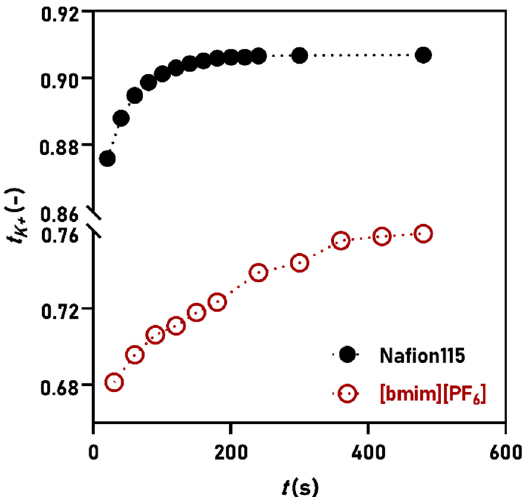
Figure 4. Time-course of K + transport numbers in the case of Nafion and [bmim][PF 6 ] membranes. Additionally, this value implies that the diffusion of ions through the SILM is not driven by any ion-selective feature of the [bmim][PF 6 ] and rather, it is proportional to the size of the ions in the electrolyte (the ratio of ion radii for K + and Cl − is r K+ /r Cl − = 0.762). This supports the assumption that protons—and consequently ions—transfer by the assis- tance of water through the IL with [PF 6 ] −